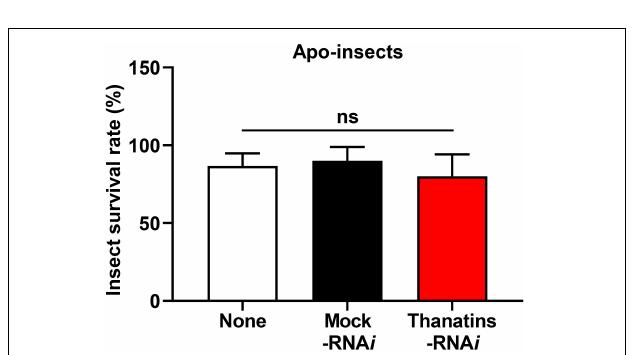
FIGURE 7 | Survival rates of the thanatin gene-silenced Apo-insect upon systemic E. coli K12 injection. Data are expressed as mean ± SD ( n = 10). Data are representative of three independent experiments (ns = non-significant) ( P < 0.05; one-way ANOVA with Tukey’s correction).